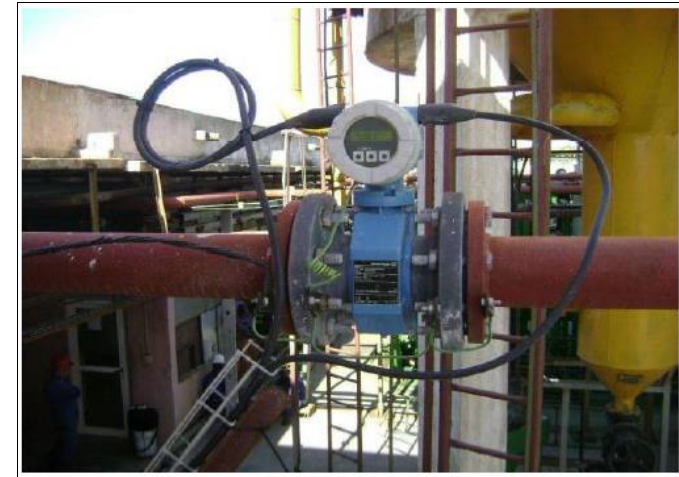
Figura 11: Configuración del sistema de automatización de los tanques de agua de la Planta de Tratamiento Químico. Fuente: Los Autores, (2015).